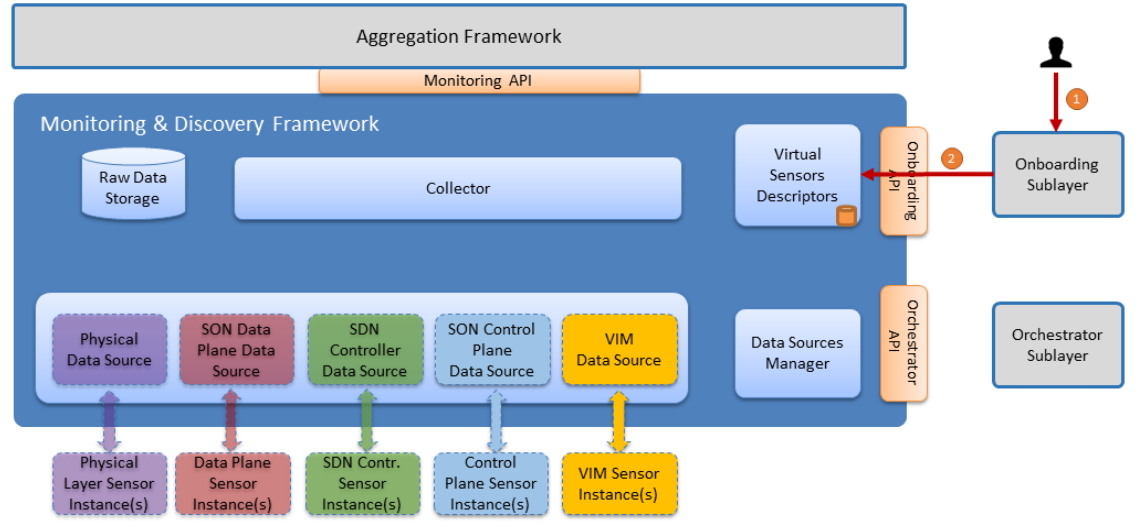
Figure 8. Sensor Onboarding Workflow.